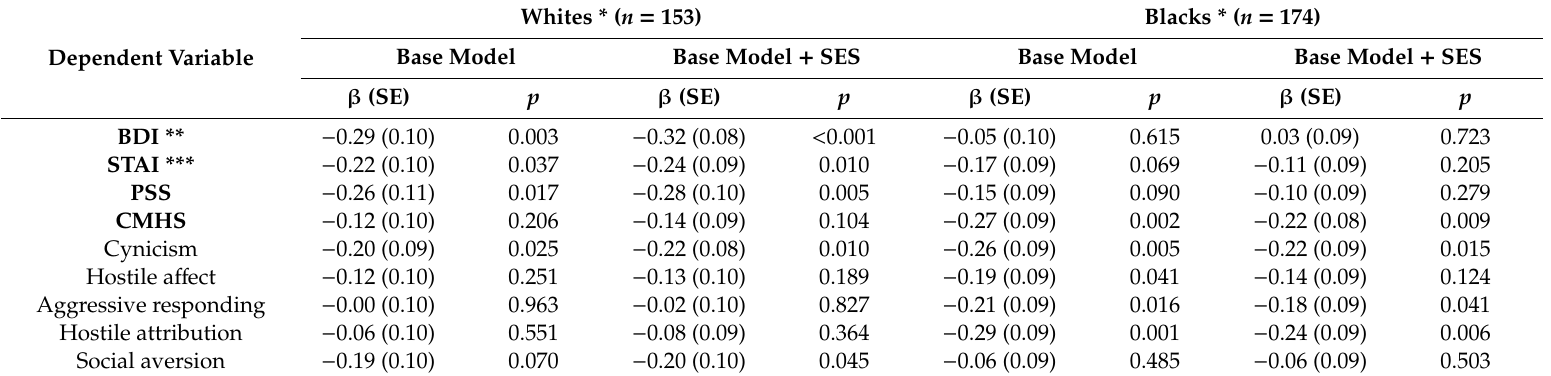
Table 4. Adjusted associations between mental health and serum 25(OH)D concentrations stratified by